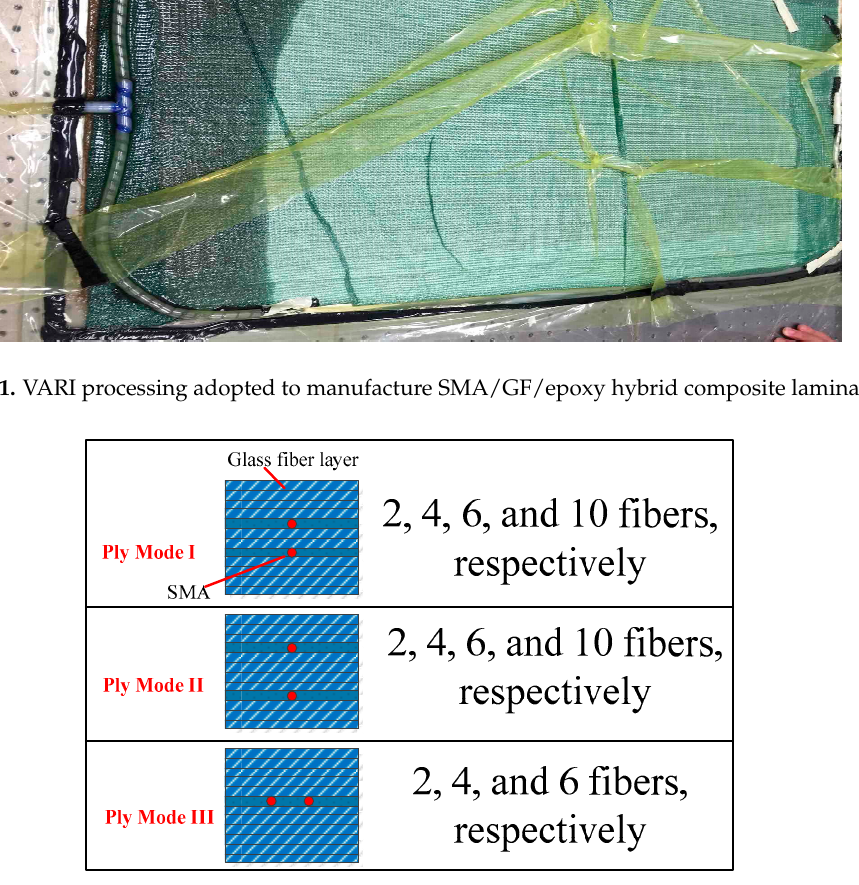
Figure 2. SMA location and their numbers in the composite laminates.